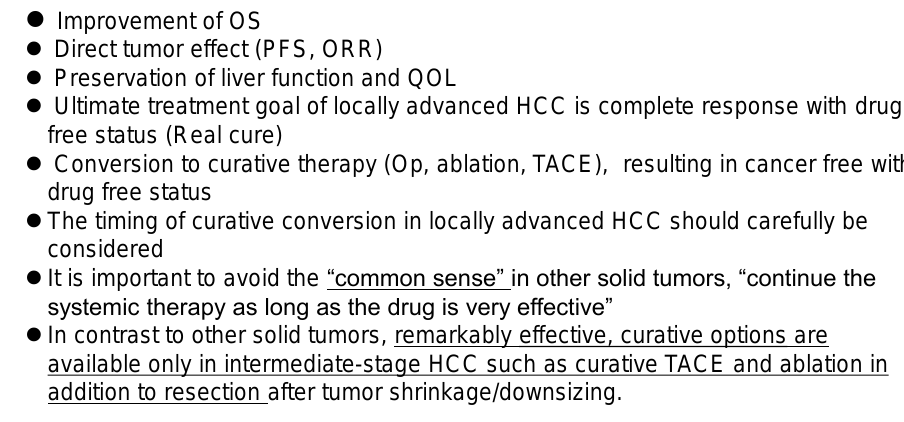
Figure 4. Treatment concept for intermediate-stage hepatocellular carcinoma. HCC— Hepatocellular Carcinoma; OS—.